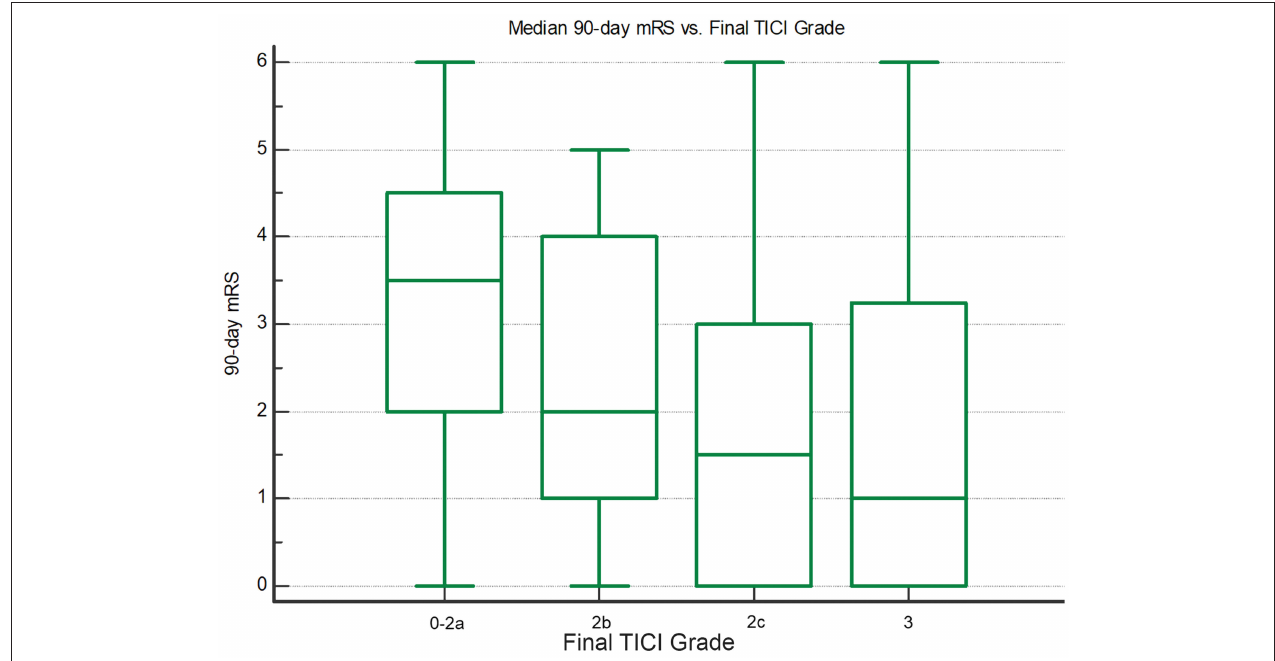
FIGURE 2 | Box-whisker plots showing median 90-day mRS vs. final TICI grade. There are significantly lower mRS scores with greater final reperfusion ( P < 0.05; Jonckheere-Terpstra trend